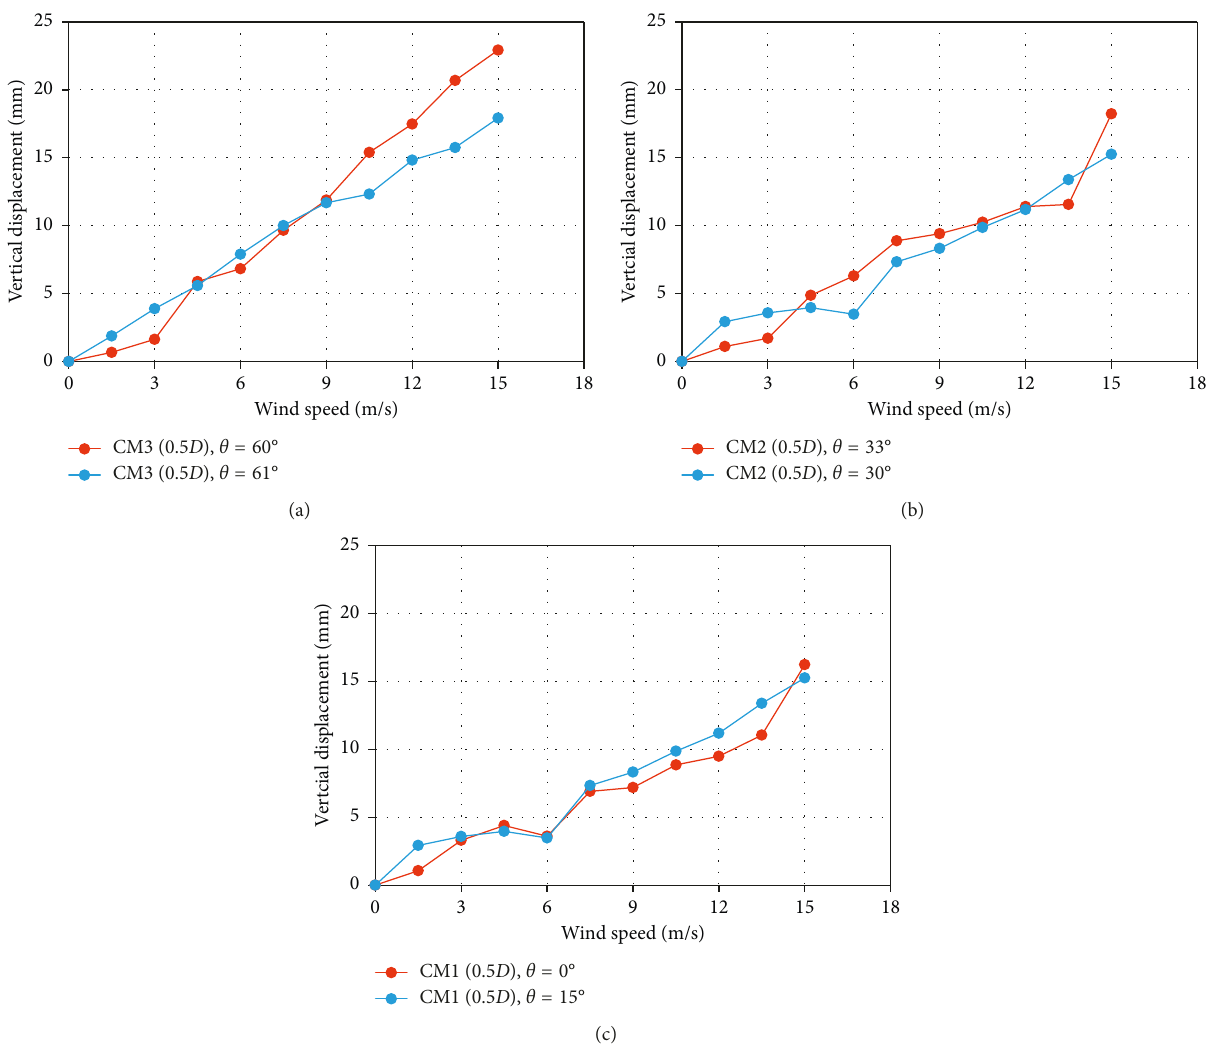
Figure 10: Variation of mean vertical response with wind speed for cable models with 0.5D ice thickness: (a) CM3 at θ � 60 ° and θ � 61 ° ; (b) CM2 at θ � 30 ° and θ � 33 ° ; (c) CM1 at θ � 0 ° and θ � 15 °